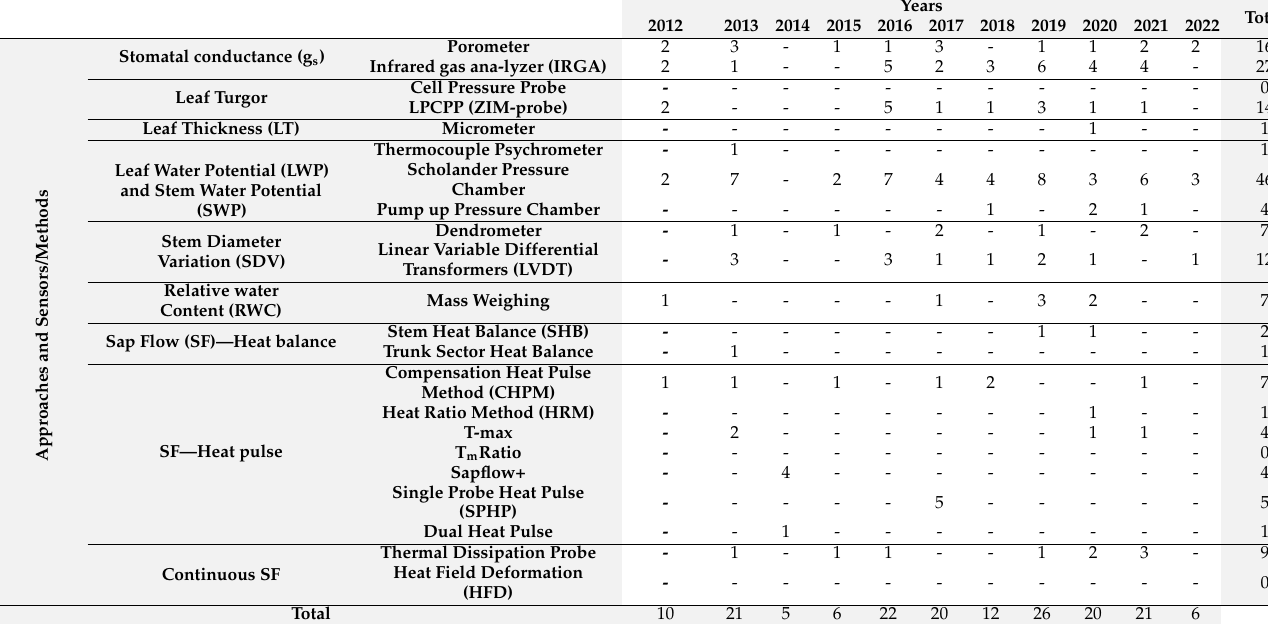
Table 2. Approaches and sensors/methods to assess plant water status for the Mediterranean fruit and nut tree crops from 2012 to